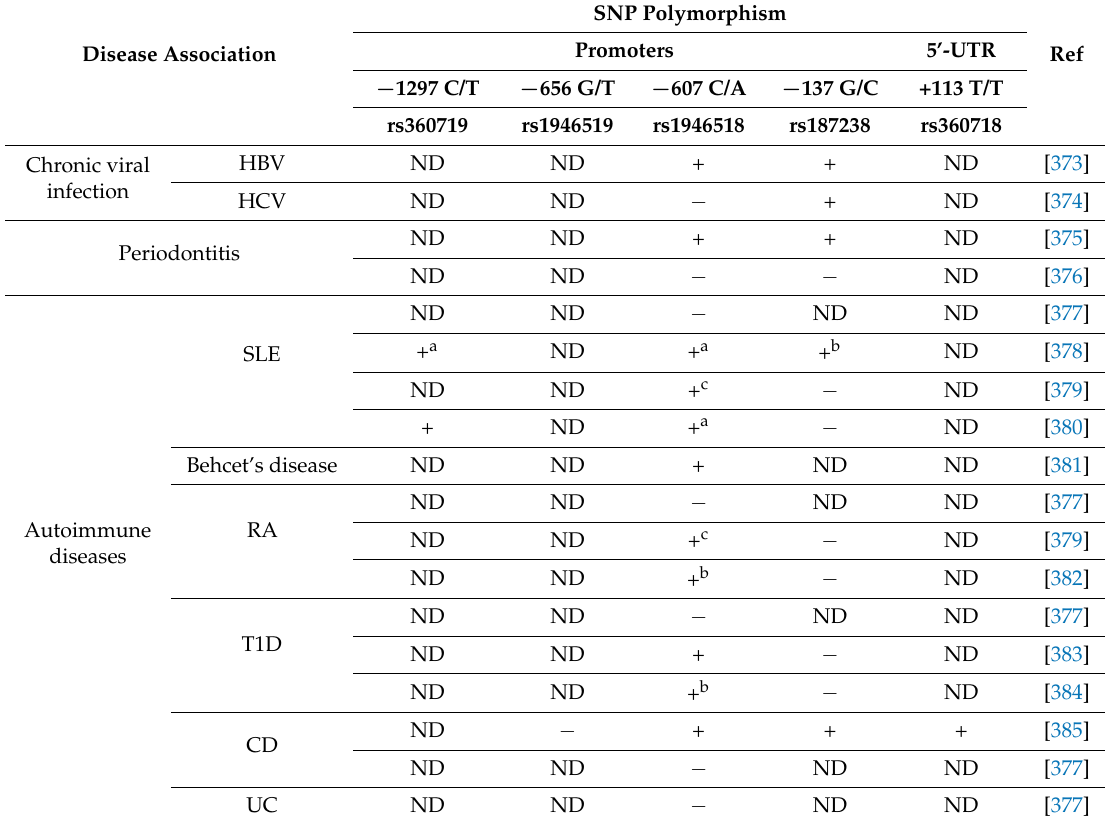
Table 1. IL-18 gene promoter polymorphisms (meta-analysis and/or systematic review).